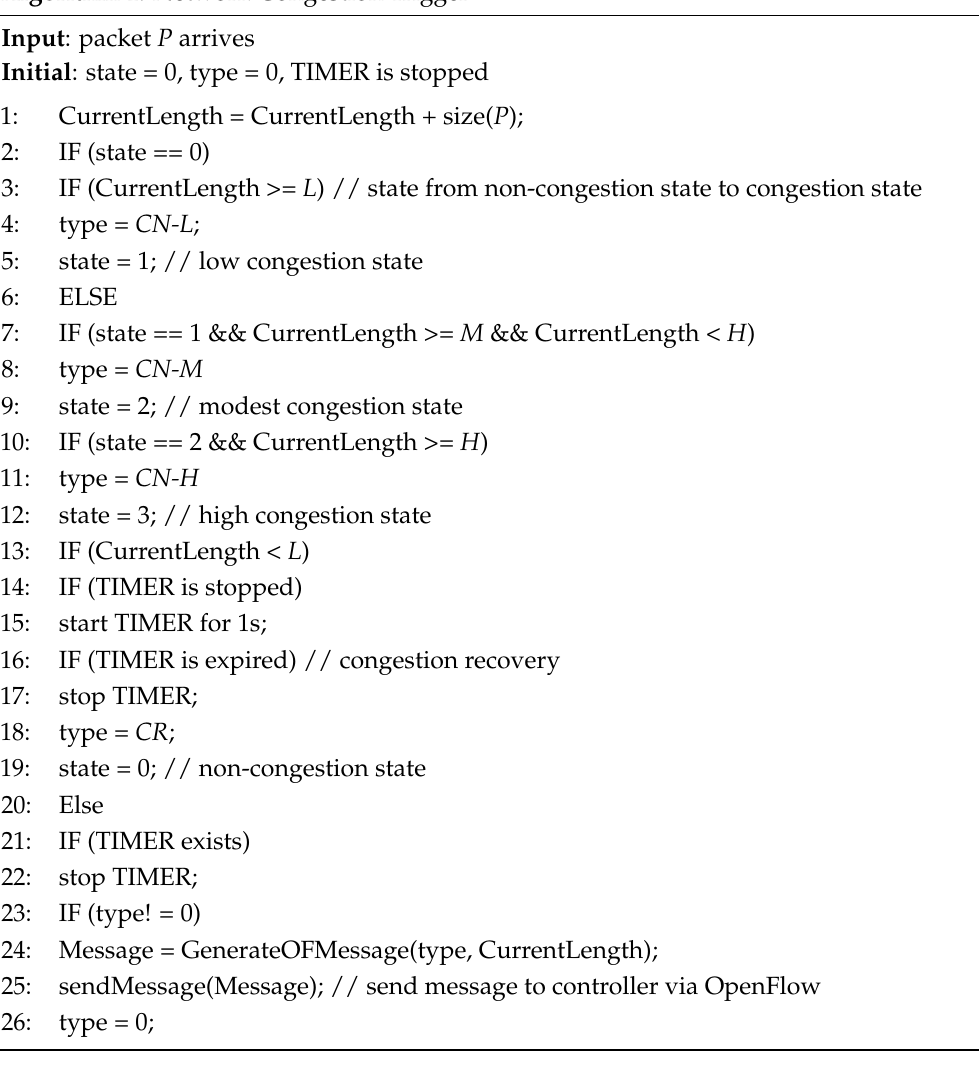
Algorithm 1. Network Congestion